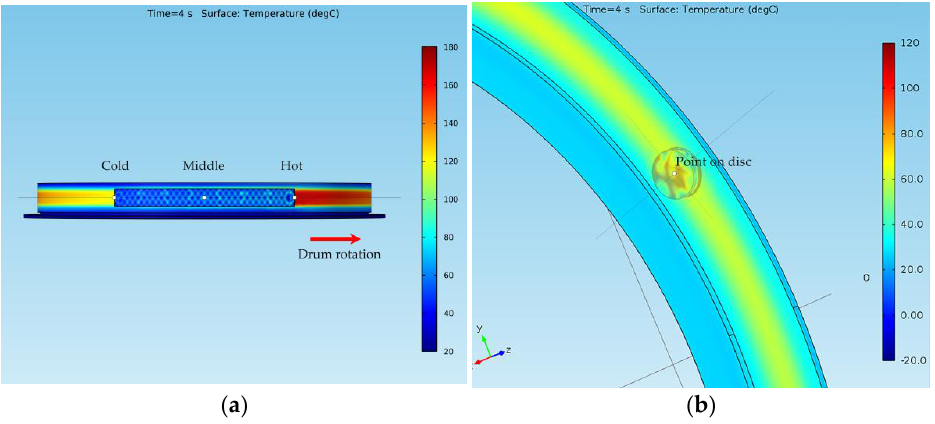
Figure 17. Points for surface temperature representation of the ( a ) drum-and-shoe brake system; ( b ) disc-and-pads brake system.